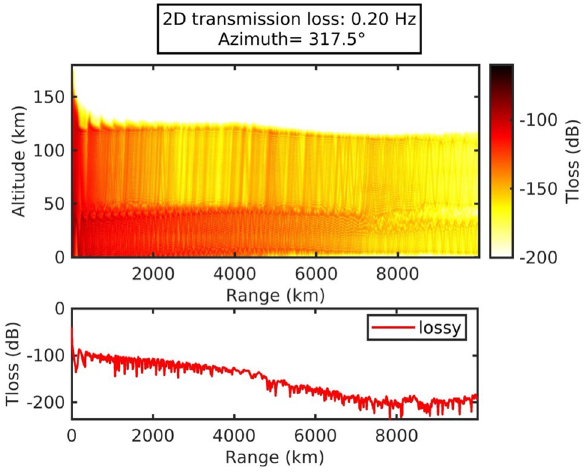
Figure 6. The 2D-transmission loss simulation by the parabolic range-dependent propagation method in the direction of the KUT sensors network (Azimuth =